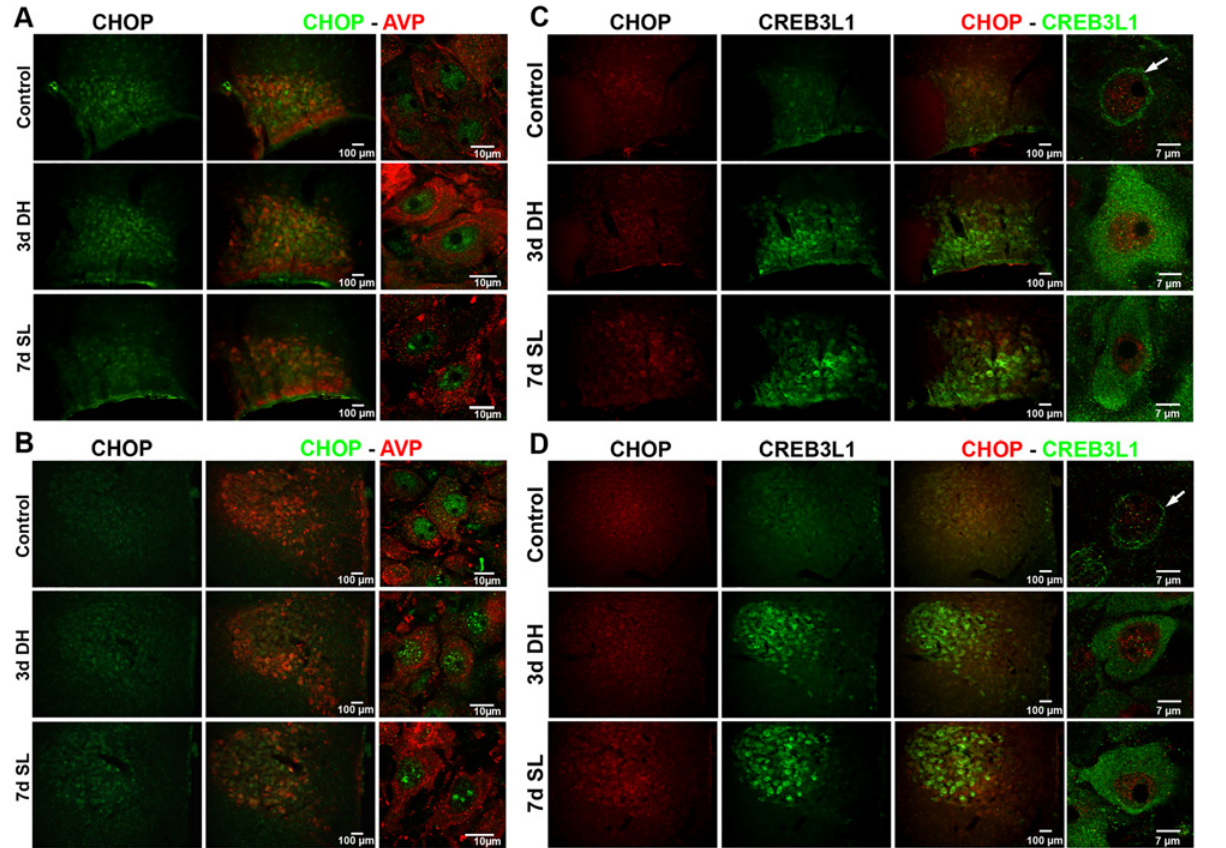
Fig 4. Localisation of CHOP in the SON and PVN. (A-B) Immunostaining of CHOP (green) and AVP (red) in the (A) SON and (B) PVN of 3 days DH and 7 days SL rats shows expression of CHOP in the nuclei of AVP MCNs. (C-D) Immunostaining of CHOP (red) and CREB3L1 (green) in the (C) SON and (D) PVN of 3 days DH and 7 days SL rats shows co-existence of CHOP and CREB3L1 in the same MCNs. High magnification confocal microscope images shows a change in localisation of CREB3L1 from perinuclear staining in control to cytoplasmic and nuclear staining in both 3 days DH and 7 days SL. Arrows indicate perinuclear staining of CREB3L1. d, day; DH, dehydration; SL, salt loading; AVP, arginine vasopressin.